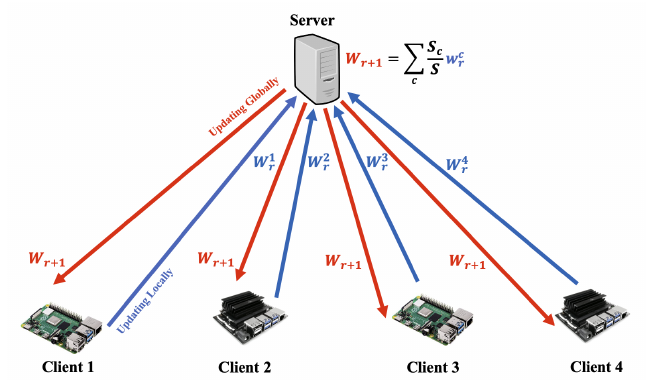
Figure 3. Federated learning